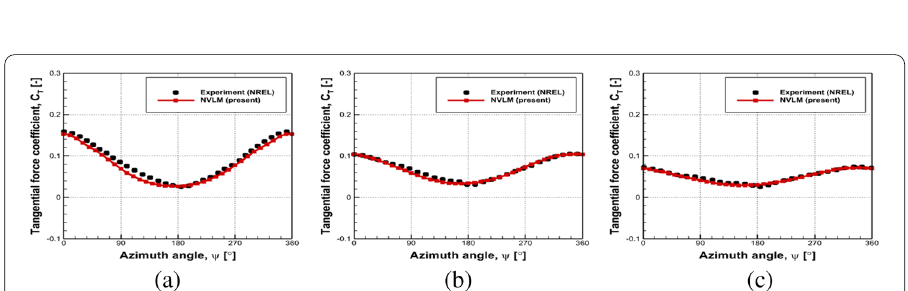
Fig. 14 Azimuthal variation of tangential force coefficient acting at specific radial positions for V β 30º: ( a ) r/R 0.47, ( b ) r/R 0.63, and ( c ) r/R = = =